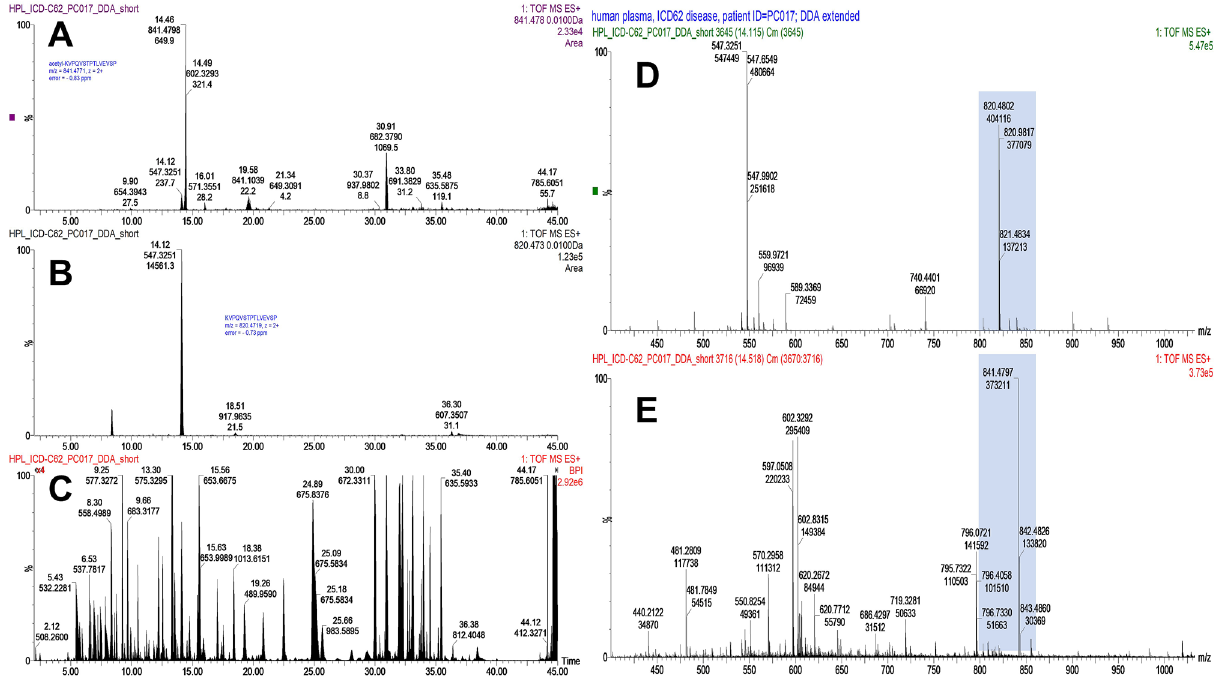
Figure 2. Overview of the targeted mass spectrometry analysis (t-MS2) exemplified on peptide KVPQVSTPTLVEVSR (ALBU) in patient with breast cancer. Extracted ion chromatograms of the modified peptide with m/z = 841.4774 2+ , mass error is -0.83 ppm detected at 14.46 min ( A ) and its intact (unmodified) counterpart peptide with m/z = 820.4719 2+ , mass error is -0.73 ppm, detected at 14.12 min and shadowed by the unknown peak with m/z = 547.3251 (charge state z = 2 +) ( B ). Base-peak chromatogram resulted after targeted MS2 analysis shown within analytical time range from 0 to 45 min and 4-folds magnified in intensity scaled ( C ). Averaged at half of maximum intensity mass spectra of the intact peptide ( D ) and modified peptide ( E ). Base peak with m/z = 547.3251 2+ is visible on the averaged spectra of the intact peptide ( D